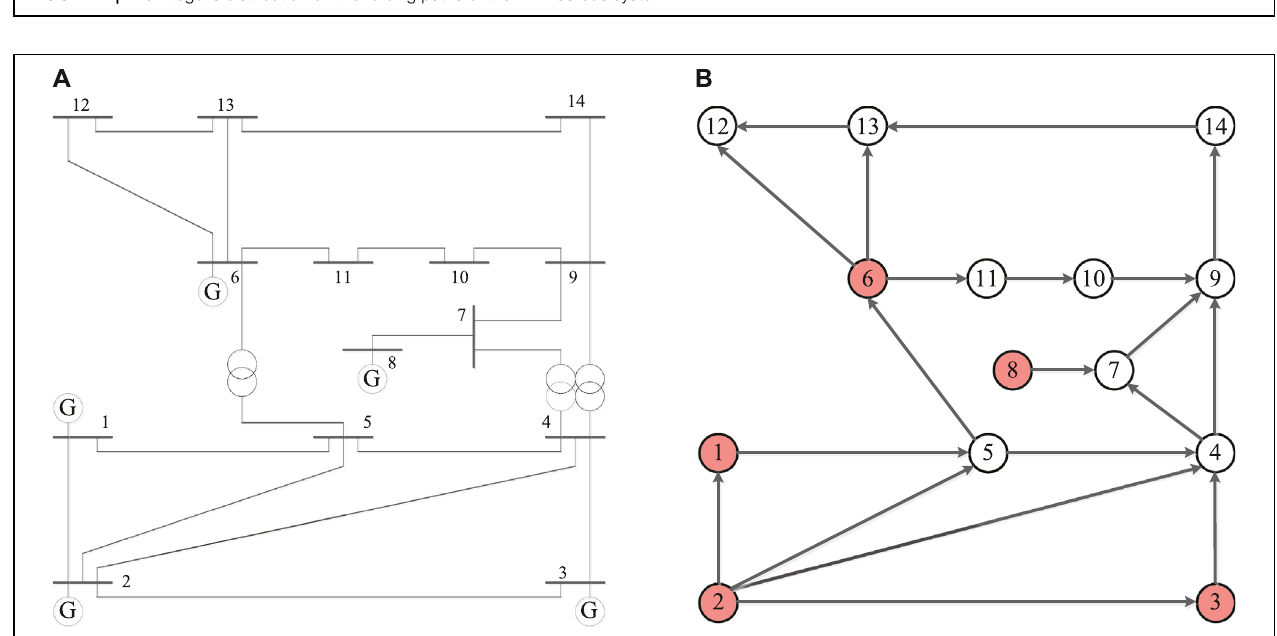
FIGURE 7 | The integer’s distribution on the forcing paths of the IEEE 39 bus system.